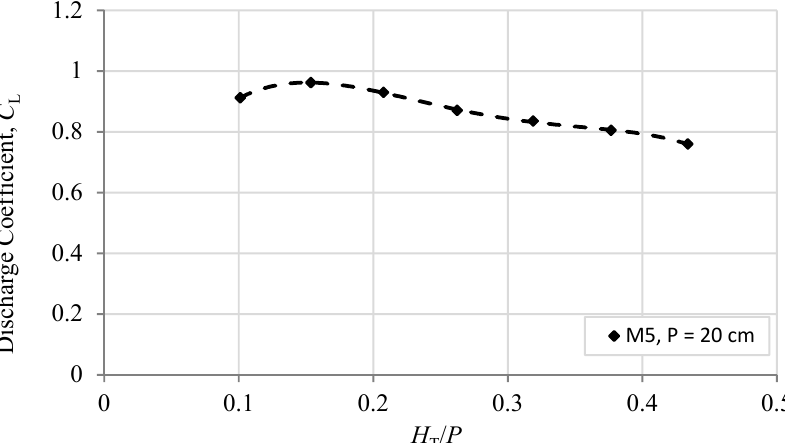
Figure 9. Variations in the discharge coefficient, C L , as a function of the H T / P ratio for the M5 model.